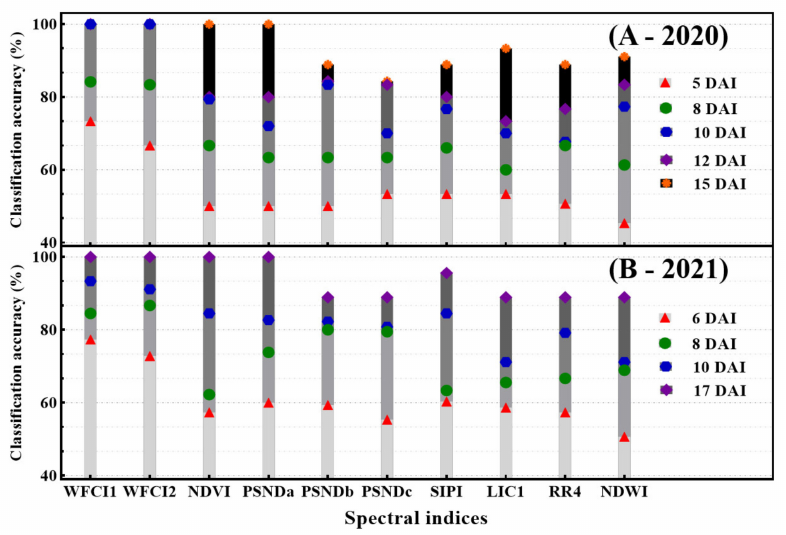
Figure 7. Comparison of average classification accuracy (ACA) of newly developed indices;